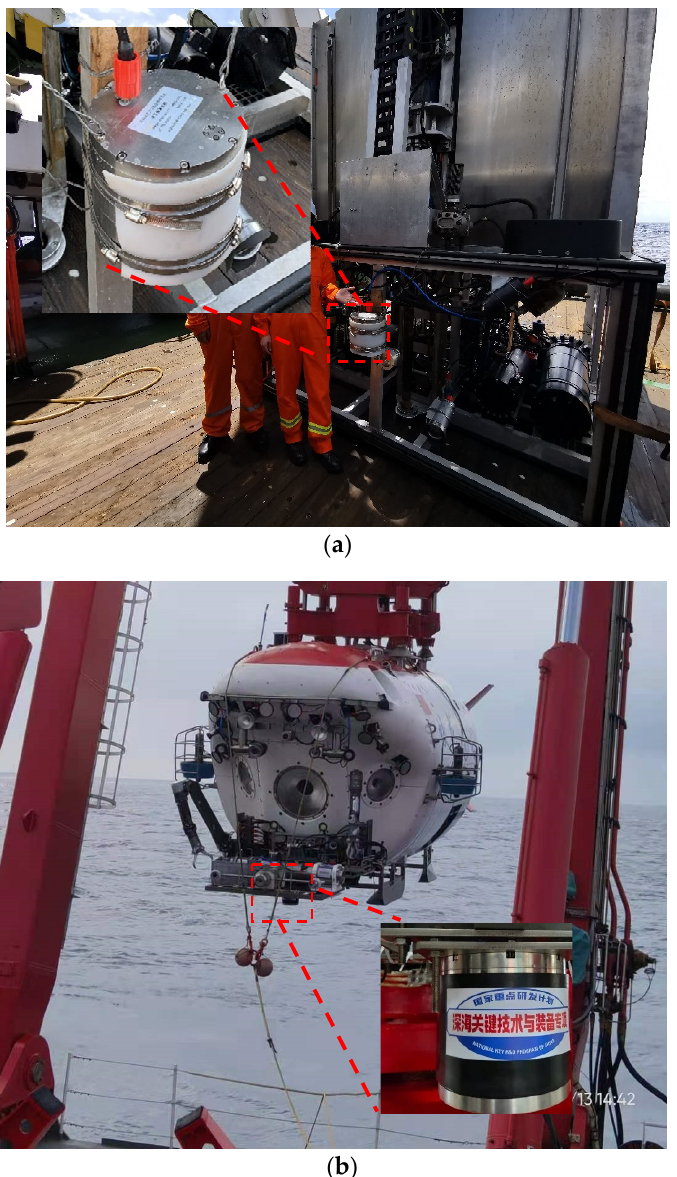
Figure 7. Experimental configurations to acquire the echo data: ( a ) PPPAAPP19 mounted on the mobile drilling rig in 2019; ( b ) PPPAAPP19 mounted on JIAOLONG HOV in 2020. The development of the device has a label that indicates it is supported by National key R&D Program.